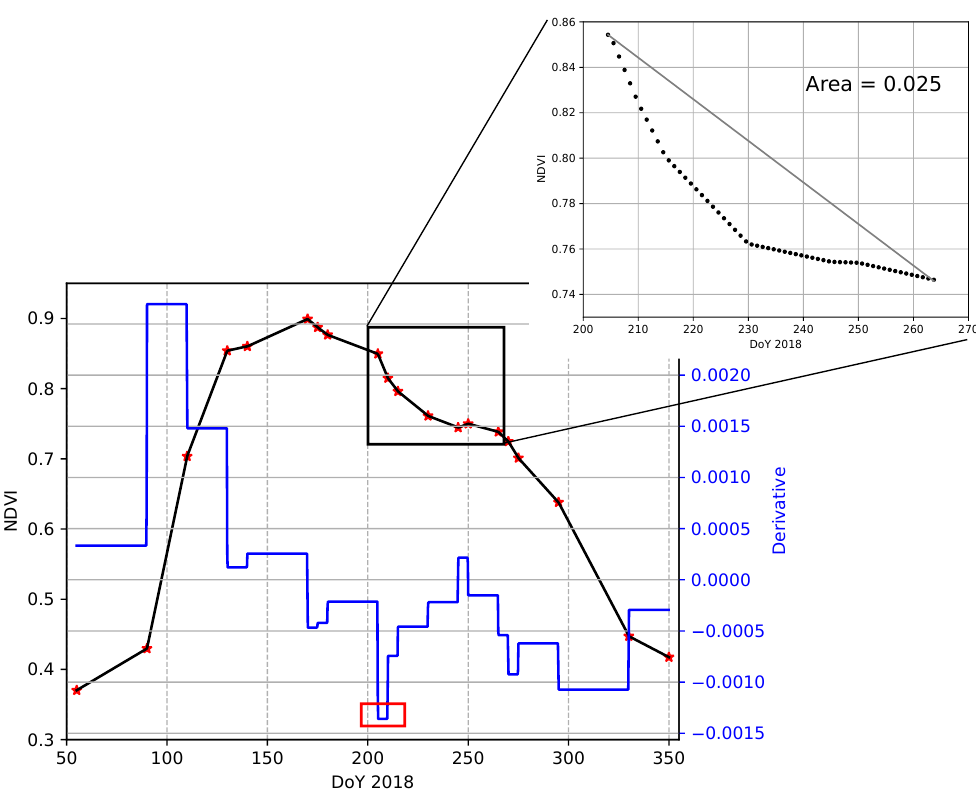
Figure 5. Phenological curve as described by NDVI in black and its derivative (SlVI t also shown in the zoomed image. The value of SlVI t period is surrounded by the red rectangle. Case study of Canal de Brienne area, Toulouse,